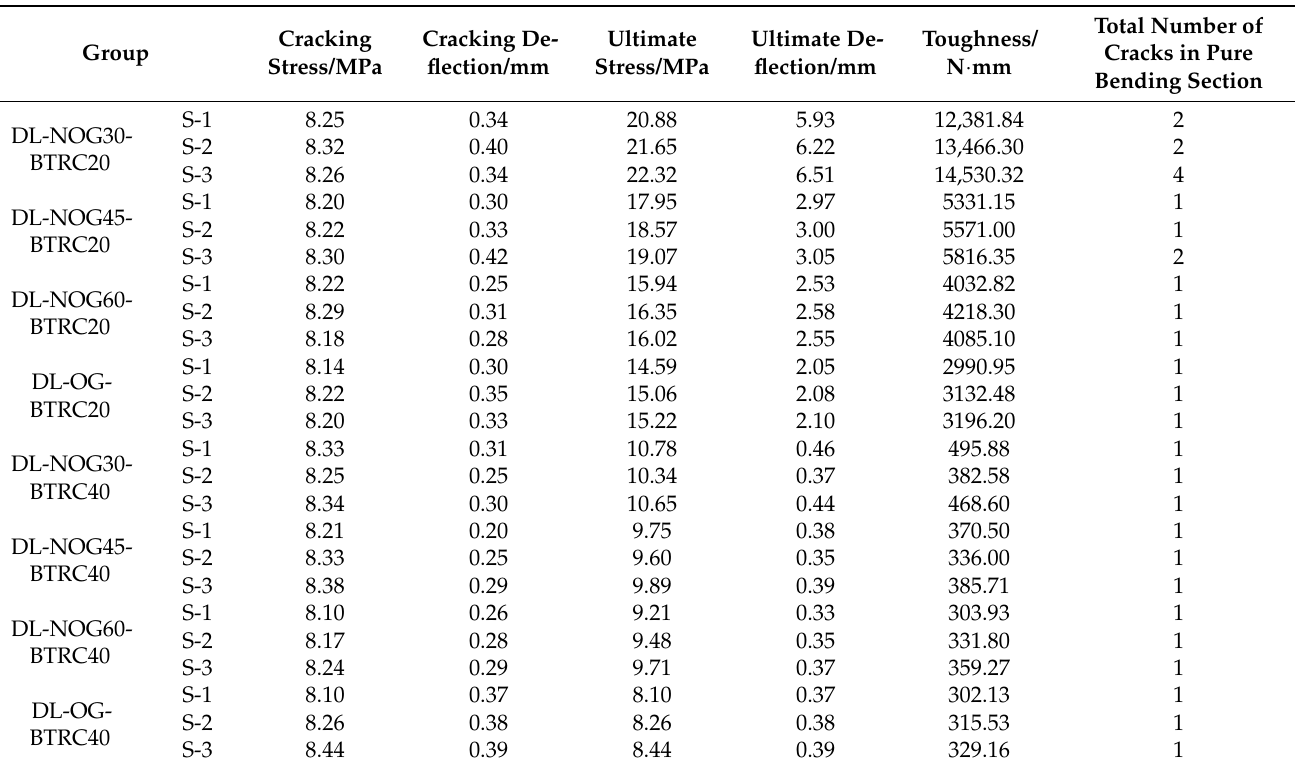
Table 5. Four-point bending tests data.